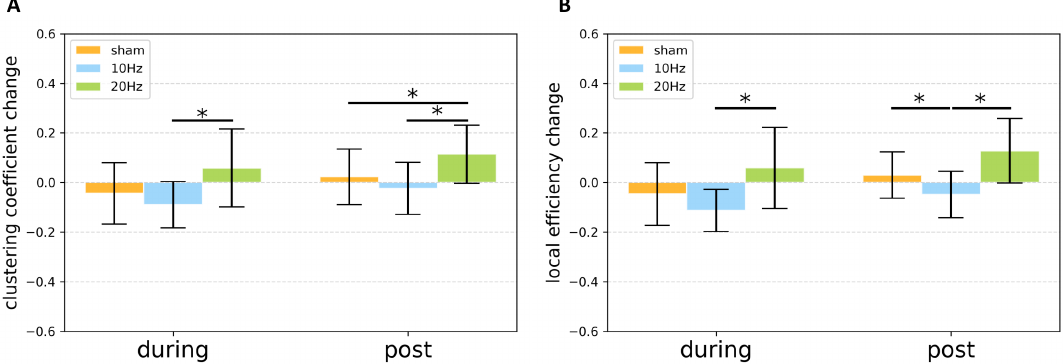
Figure 6. The bar chart of ( A ) clustering coefficient change and ( B ) local efficiency change of the network in motor-related regions for various conditions during and after stimulation. Error bar stands for the standard error. Asterisk (*) indicates that a significant difference was observed at p <